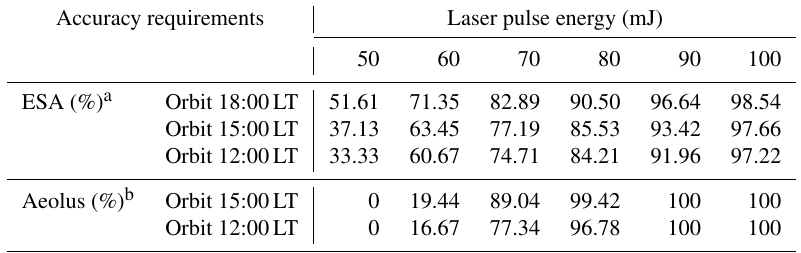
Table 3. Percentages of bins which will meet the specific accuracy requirements with certain laser pulse energies for spaceborne DWLs. Accuracy requirements